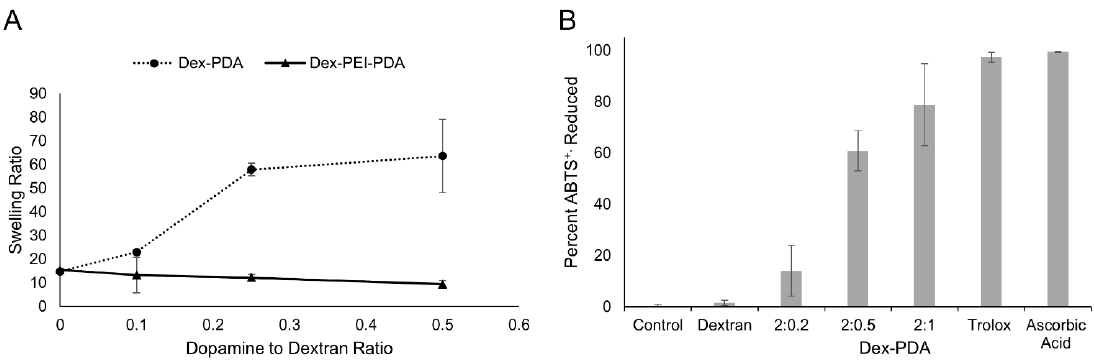
Figure4. ( A )Swellingratiosfordex-PDAhydrogelsindeionizedwaterwithfeedratiosranging2:1–2:0.2 Figure 4. ( A ) Swelling ratios for dex-PDA hydrogels in deionized water with feed ratios ranging 2:1– (dextranhydrogelhasnoPDApresent)anddex-PEI-PDAhydrogelswithfeedratiosranging2:1:1–2:1:0.2 (dex-PEI hydrogel has no PDA present). ( B ) The 2,2 (cid:48) -Azino-bis(3-ethylbenzothiazoline-6-sulfonic acid) diammonium salt (ABTS) antioxidant assay of dex-PDA hydrogels with feed ratios ranging 2:1–2:0.2. Negative controls of dextran hydrogel without PDA and water were used. For a positive control antioxidants Trolox and ascorbic acid were used.